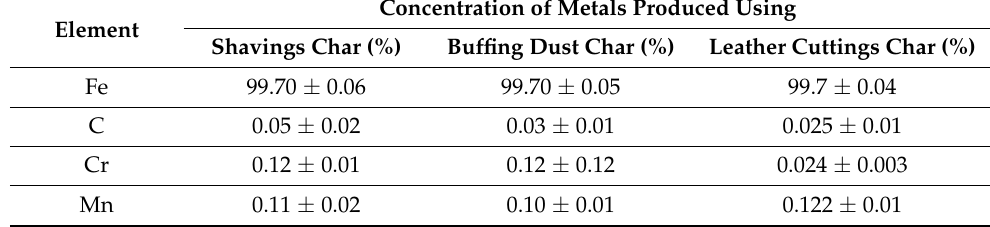
Table 4. Elemental analysis of metal droplets produced from the reduction of iron (III) oxide